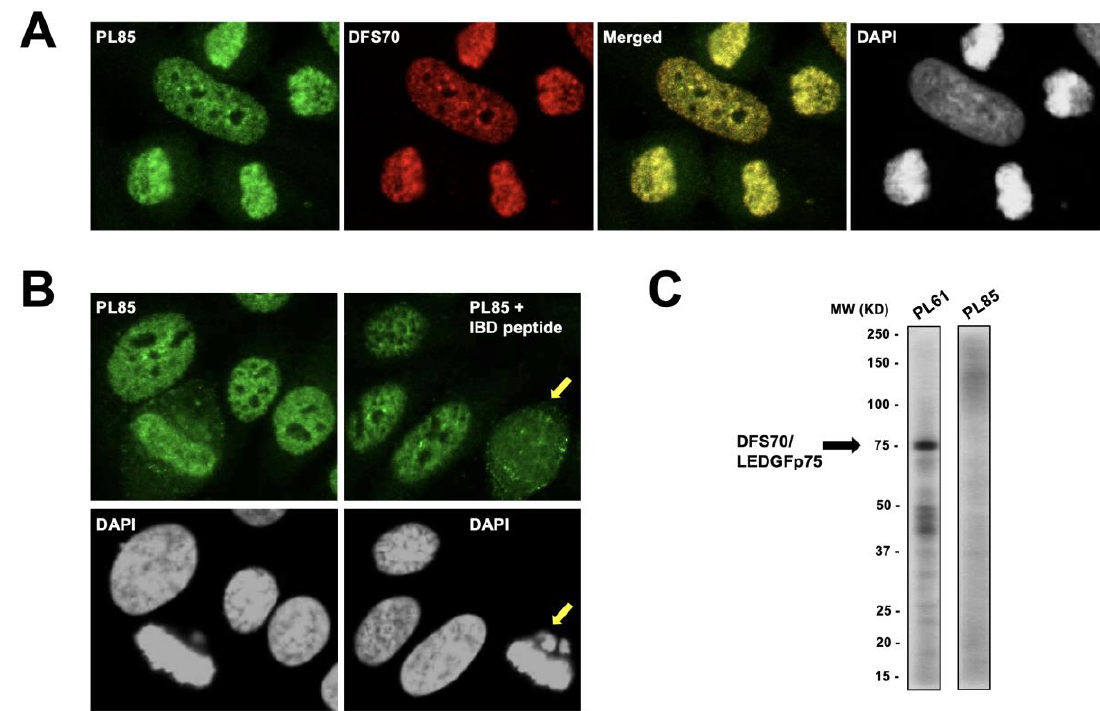
Figure 5. Analysis of CLIA anti-DFS70-negative serum PL85. ( A ) The monospecific pseudo-DFS IFA pattern from serum PL85 (green) shows extensive co-localization with the IFA pattern produced by the DFS70/LEDGFp75 rabbit antibody (red) in HEp-2 cells as revealed by the widespread yellow fluorescence in the merged images. ( B ) Pre-adsorption of serum PL85 with IBD peptide abolished the metaphase chromosome staining (yellow arrows) but not the interphase nuclear DFS staining. Fluorescent images were obtained by confocal microscopy. Chromatin staining with DAPI is presented in black and white for better visualization. ( C ) Immunoblotting analysis (total PC3-DR proteins) of PL85 serum antibodiesfailed to reveal any defined reactivity against protein bands as compared to the distinct reactivity of CLIA anti-DFS70-positive serum PL61 with DFS70/LEDGFp75.